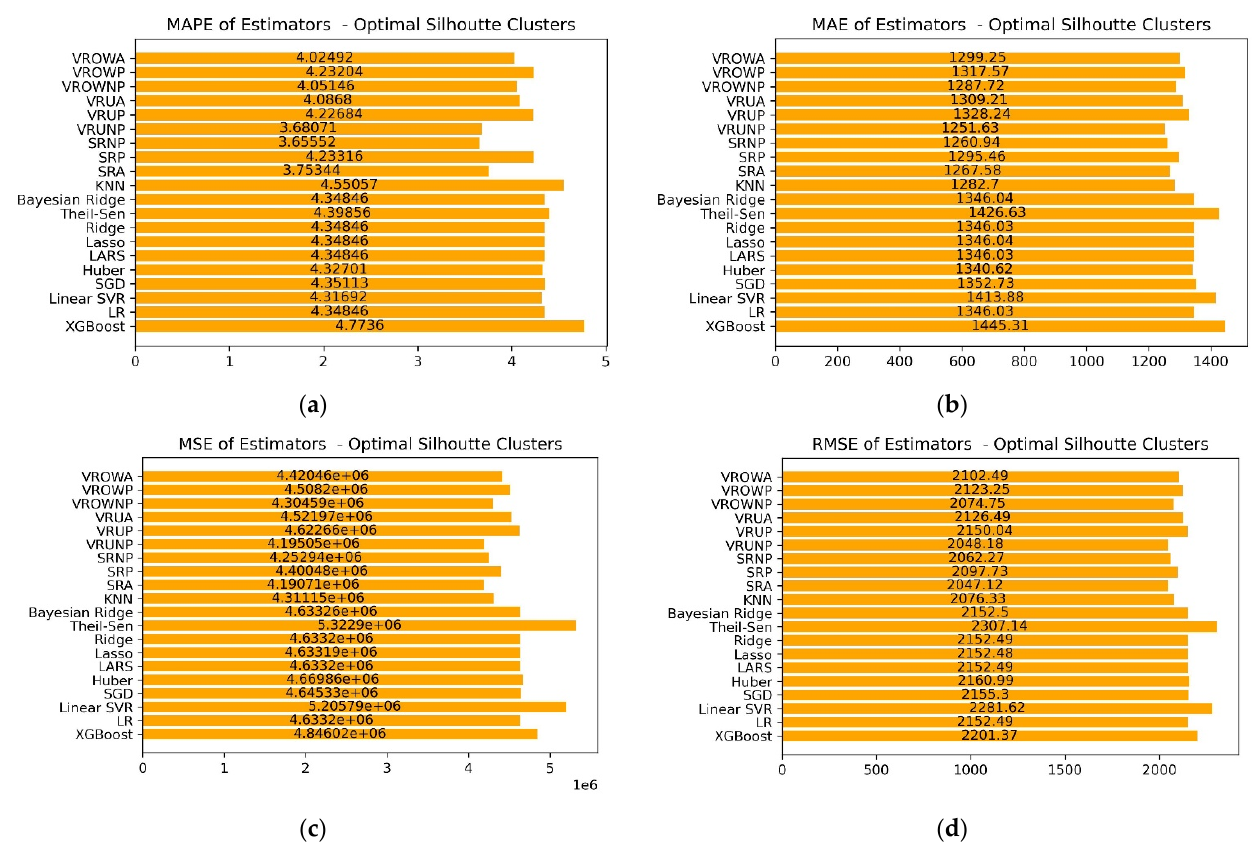
Figure 15. Error metric comparison for standalone estimators and structural ensemble models given the optimal clustering denoted by the silhouette method. The panels present the following metrics: ( a ) Mean absolute percentage error. ( b ) Mean absolute error. ( c ) Mean squared error. ( d ) Root mean squared error.